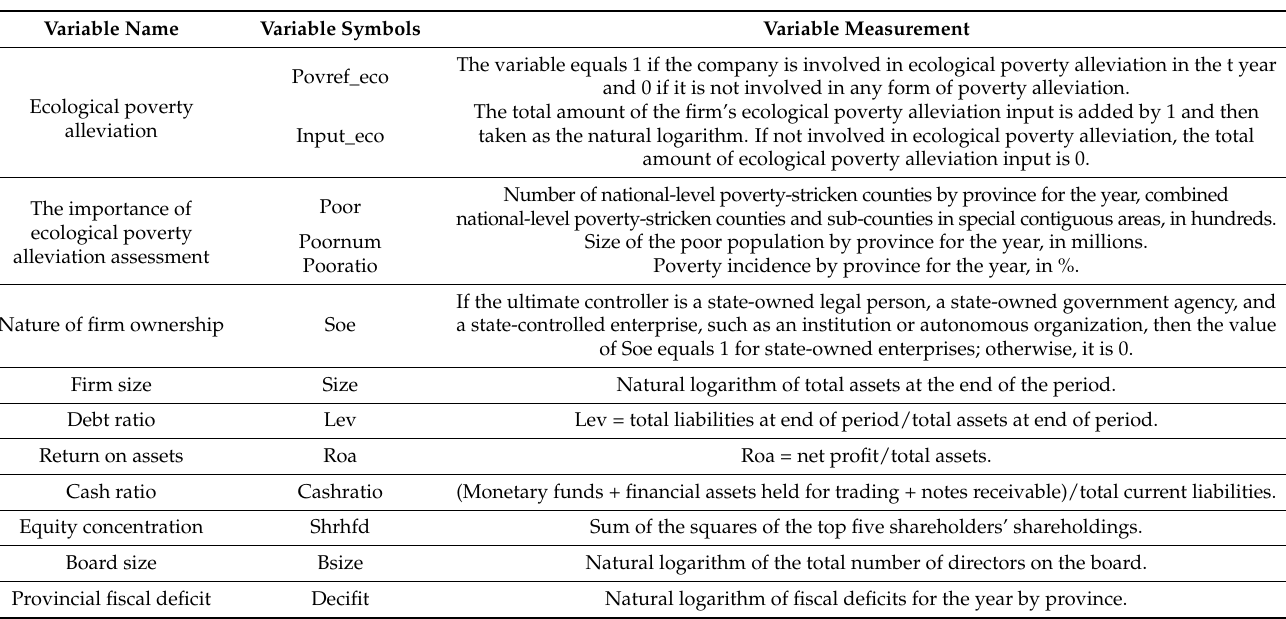
Table A1. Definition of variables.